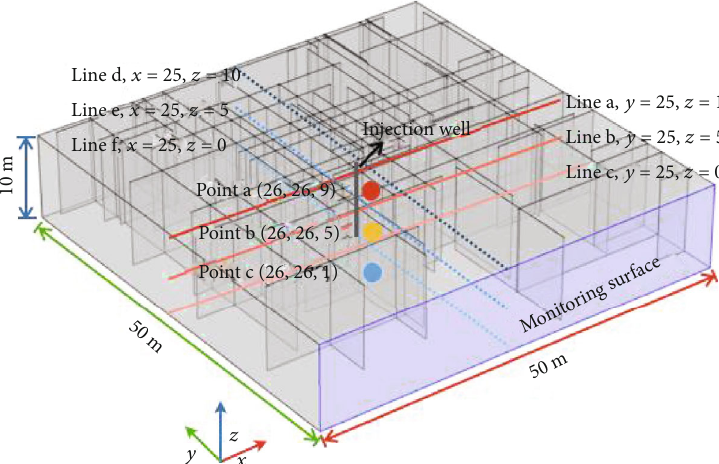
Figure 11: Scheme depicting model domain, fracture con fi guration, monitoring surface, lines, and points for the three-dimensional